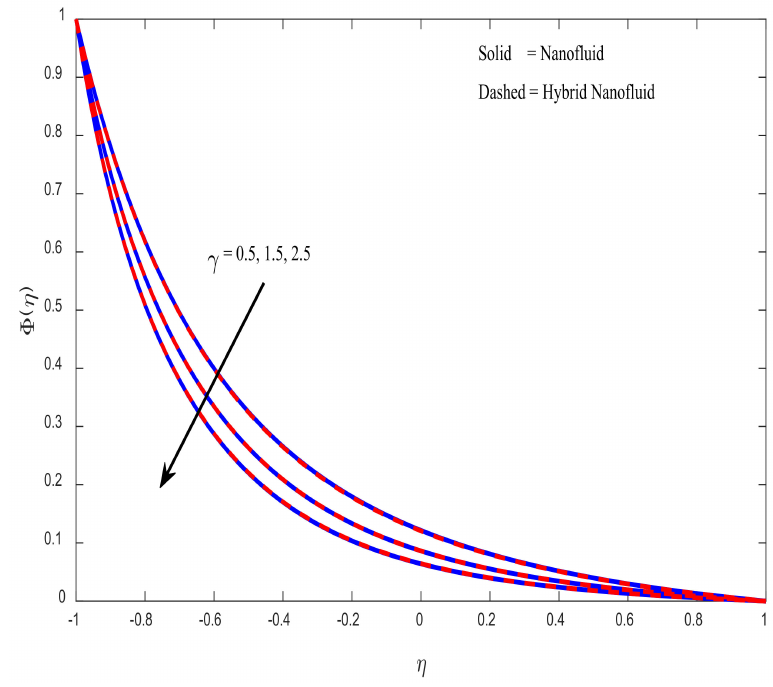
Figure 9. Influence of γ on the concentration profile.